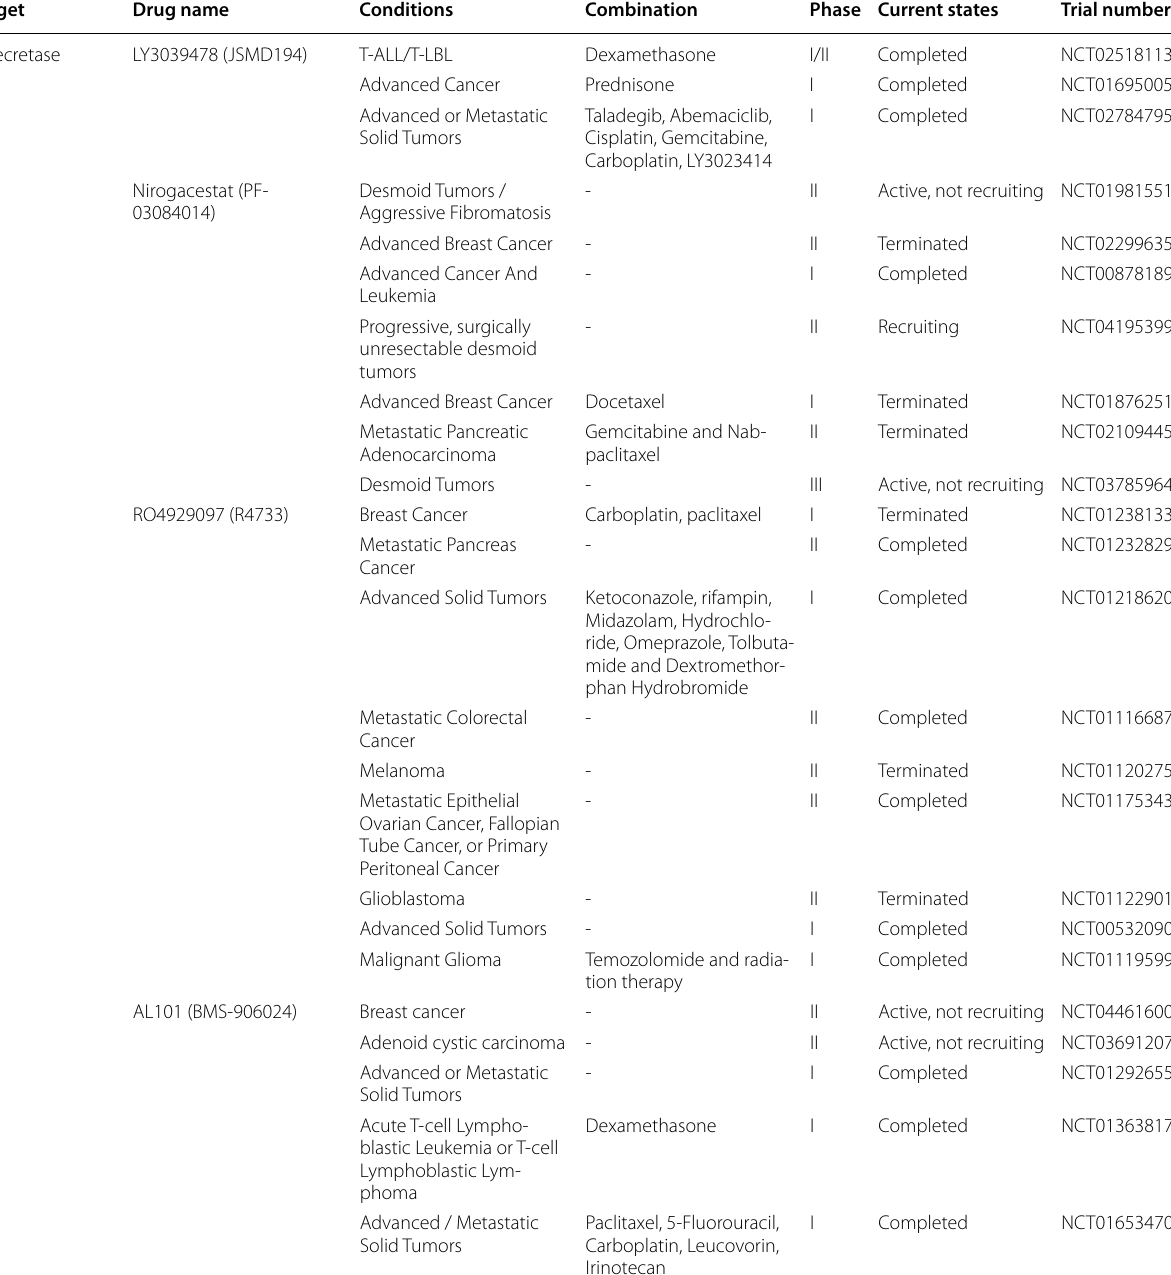
Table 1 Recent clinical trials targeting the Notch pathway